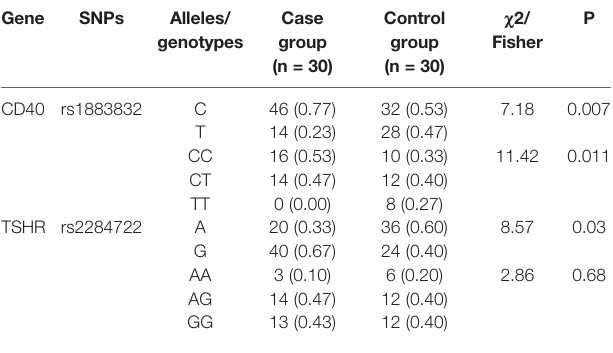
TABLE 7 | SNPs showing associations with